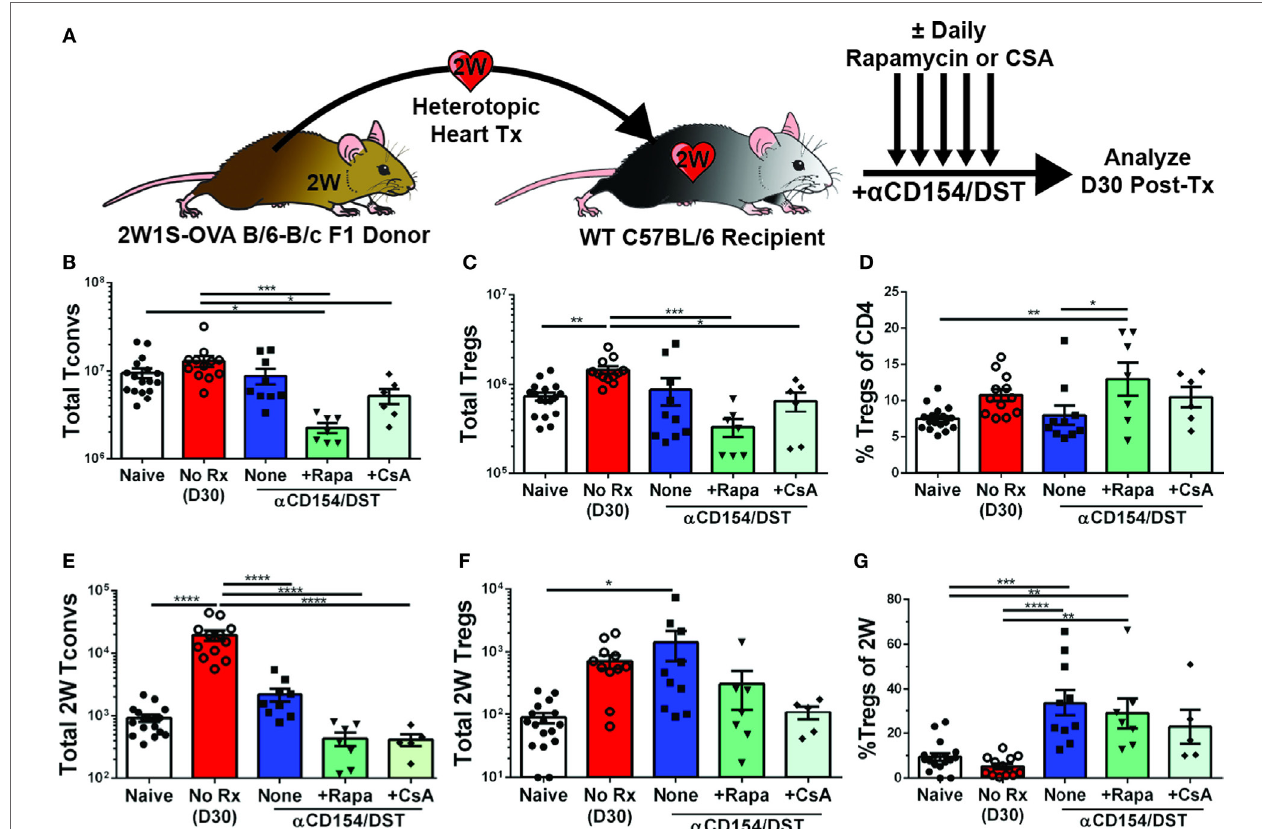
FigUre 2 | Rapamycin and cyclosporine A (CsA) inhibit expansion of allospecific conventional T cell (Tconv) but do not promote regulatory T cell (Treg) accumulation in costimulatory blockade-induced tolerant recipients. C57BL/6 recipients were transplanted with heterotopic heart allografts from Act.2W-OVA + BALB/c × C57BL/6 F1 donors as described in Figure 1 . Some recipients were untreated (No Rx), or treated with α CD154/DST also received daily injections of 2.5 mg/kg rapamycin or 50 mg/kg CsA, and all recipients were sacrificed on 30 days post-transplantation. Data for the naïve and anti-CD154/DST groups are from Figure 1 . (a) Cartoon depicting experimental design. (B) Total splenic CD4 + FoxP3 – Tconv and (c) CD4 + FoxP3 + Tregs. (D) Percentage of FoxP3 + cells among CD4 + T splenocytes. (e) Splenic 2W:I-A b (2W)-specific Tconvs and (F) Tregs were enumerated. (g) Percentage of Tregs among 2W-specific CD4 + T splenocytes. * p < 0.01, ** p < 0.01, *** p < 0.001, **** p < 0.0001 by one-way ANOVA. Mean ± SEM is shown, and each point represents one mouse from 3–4 replicate experiments (